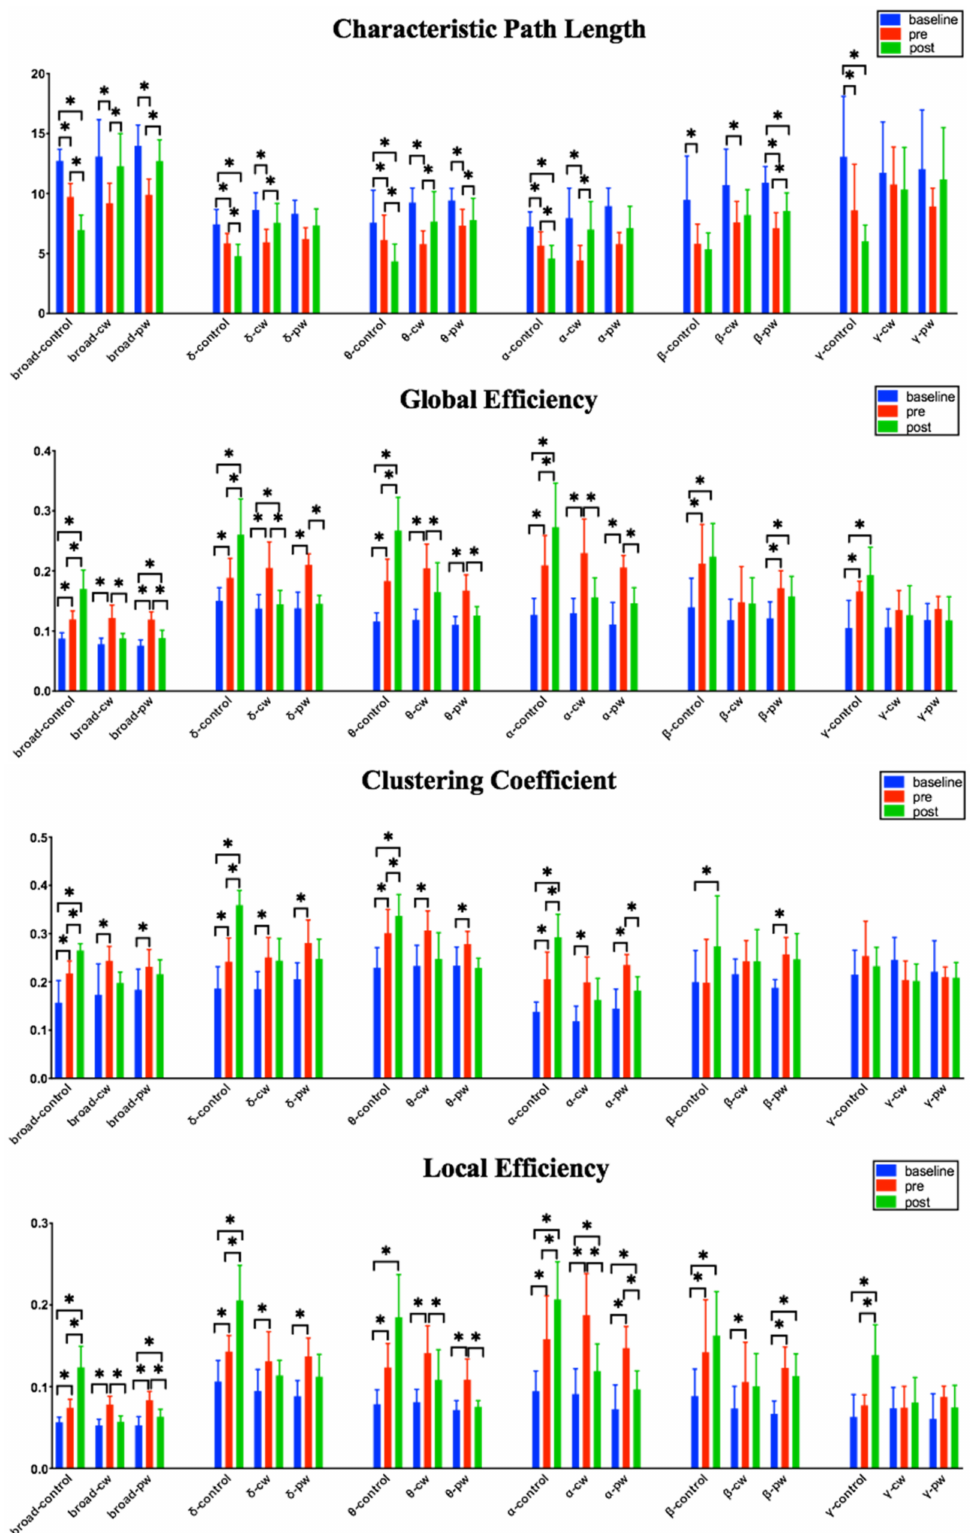
Figure 10. Intragroup analysis comparisons of brain functional connectivity indicators (L p , C p , E g , and E loc ) for all filtered bands (delta 0.1–4 Hz, theta 4–8 Hz, alpha 8–13 Hz, beta 13–30 Hz, and gamma 30–48 Hz) and the broad-filtered EEG (0.1–48 Hz). * p <